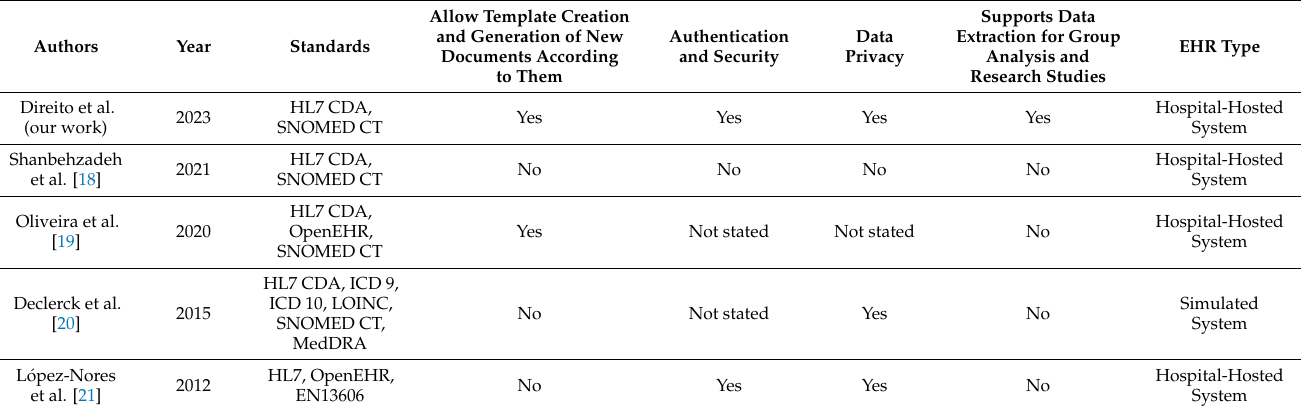
Table 4. Summary of the previous work in comparison to our